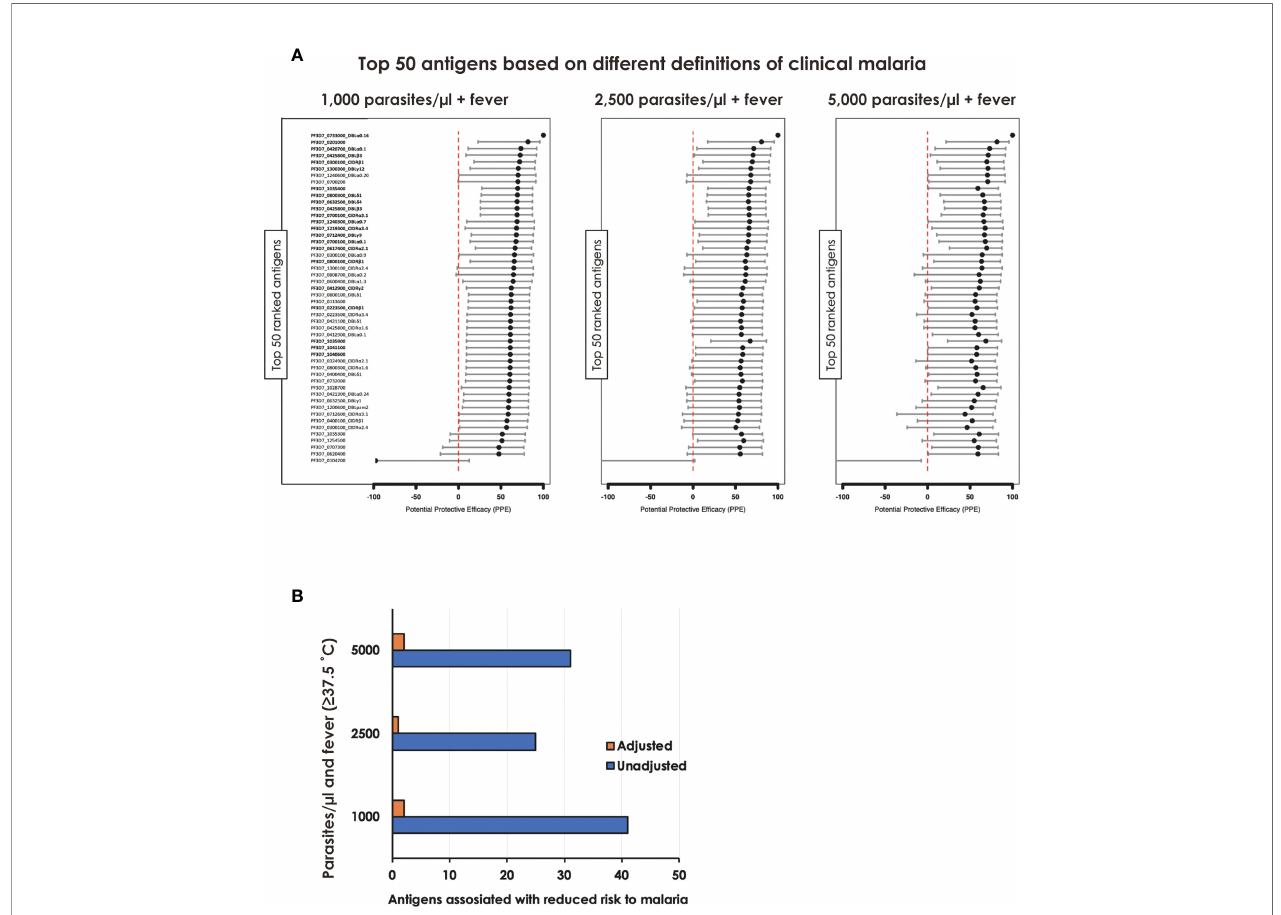
FIGURE 2 | Associations between antibody levels and risk of P. falciparum febrile malaria. Complete list of the data for potential protective ef fi cacy (PPE), and 95% con fi dence interval, is provided in Table 1 . (A) Unadjusted association between antibody levels and risk of P. falciparum febrile malaria for each of the antigens tested in the cohort. The top-50 antigens are ranked - top to bottom - by the strength of their PPE. PPE for each antigen was derived from the hazard ratio (HR) calculated by the unadjusted Cox-regression hazard model analysis (comparing children with high vs. low antibody responses). Black dots indicate the percentage protection, and error bars indicate the 95% con fi dence interval. The red vertical line represents a PPE of 0% (i.e. HR = 1). The 22 cross-selected antigens are labeled in bold. (B) The bars represent the number of antigens that associated with protection to clinical malaria in univariate and multivariate analysis. Red bar: Adjusted, Blue bar: